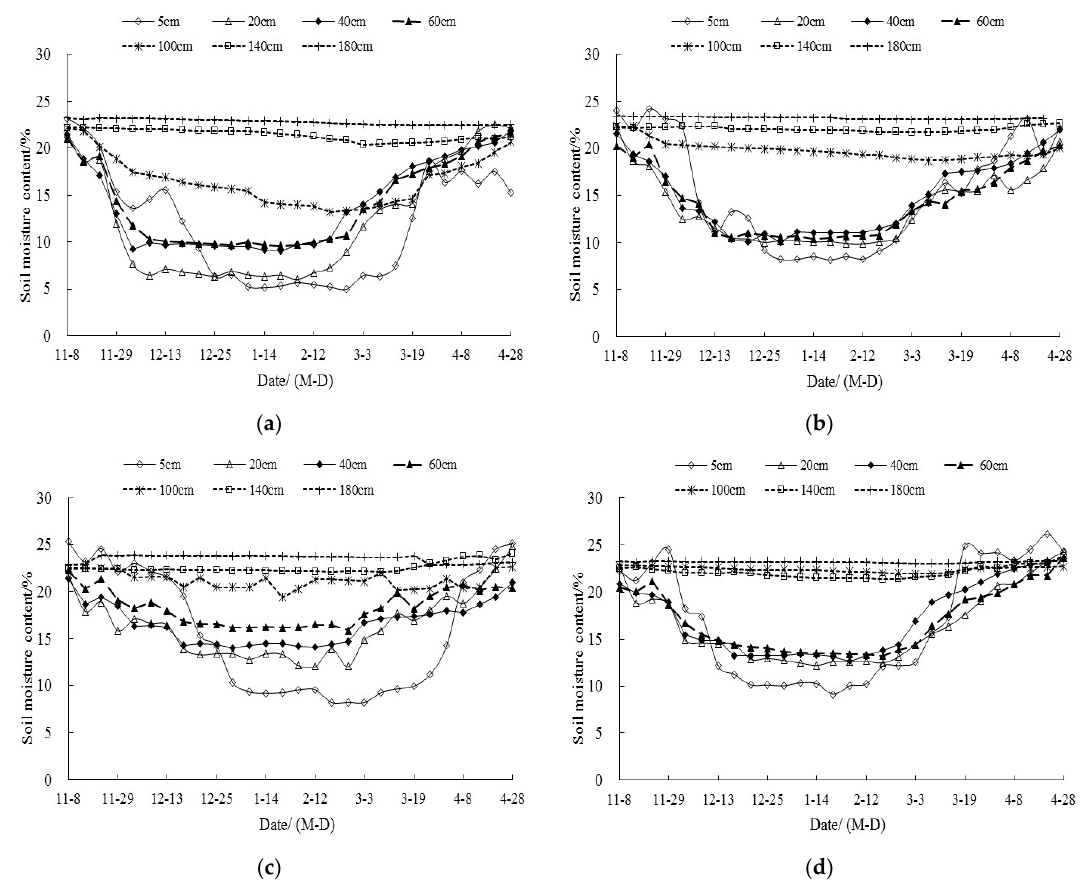
Figure 7. Variation in soil water content under different snow cover treatments. ( a ) Bare land; ( b ) natural snow; ( c ) compacted snow; ( d ) thick snow. Table 5. Analysis of soil water content variability in unit soil layers under different snow cover treatments. Bare Land Natural Snow Compacted Snow Thick